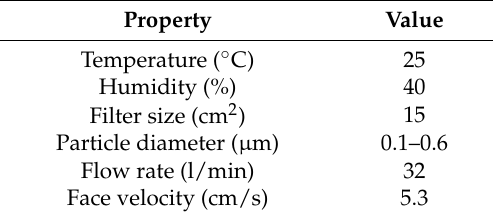
Figure 5. Schematic diagram for the performance evaluation of the PAN nanofiber air filters. Table 4. Experimental conditions to evaluate PAN nanofiber air filter A, B performance by TSI ‐ 3160.